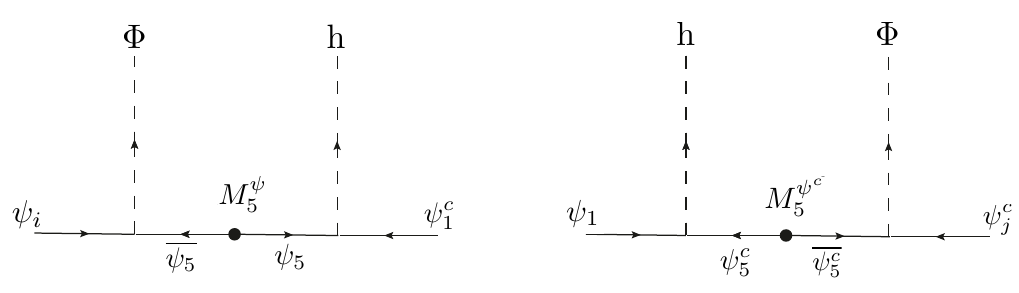
Figure 3 . Diagrams which contribute effectively to the first column (left panel) and first row (right panel) of the Yukawa matrices, where i, j = 2 , 3 are the only non-zero values. In the right panel, we have dropped the distinction between Φ and Φ 0 for